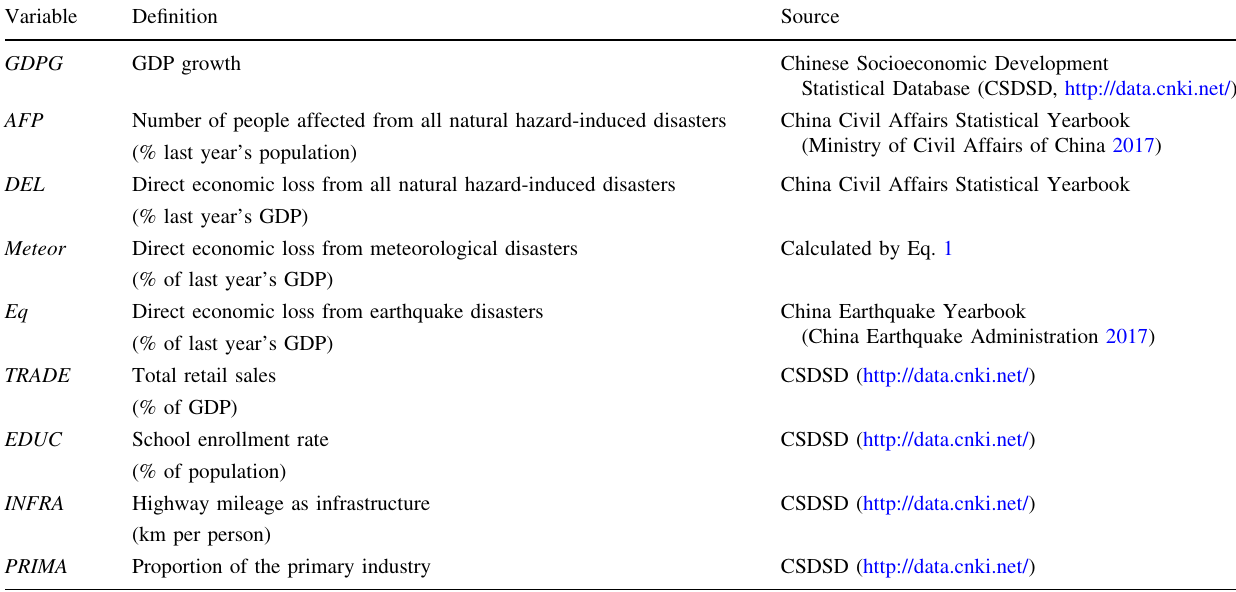
Table 1 Data sources of the study on macroeconomic consequences of natural hazard-induced disasters in China, 1990–2016